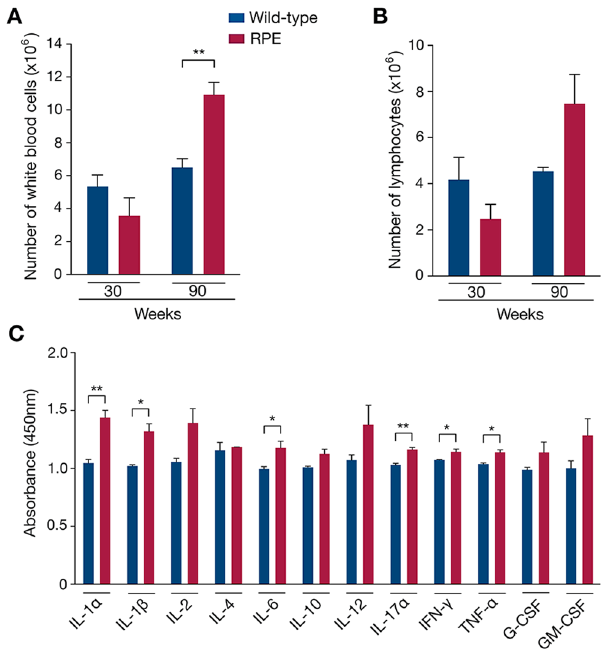
Figure 6. Systemic inflammation activation in response to sWAT depletion in RPE mice. ( A – C ) Systemic inflammation was evaluated first by whole-blood analysis, giving the number of total white blood cells ( A ) and lymphocytes ( B ), then by ELISA giving the levels of circulating pro-inflammatory cytokines ( C ), in RPE and wild-type mice.